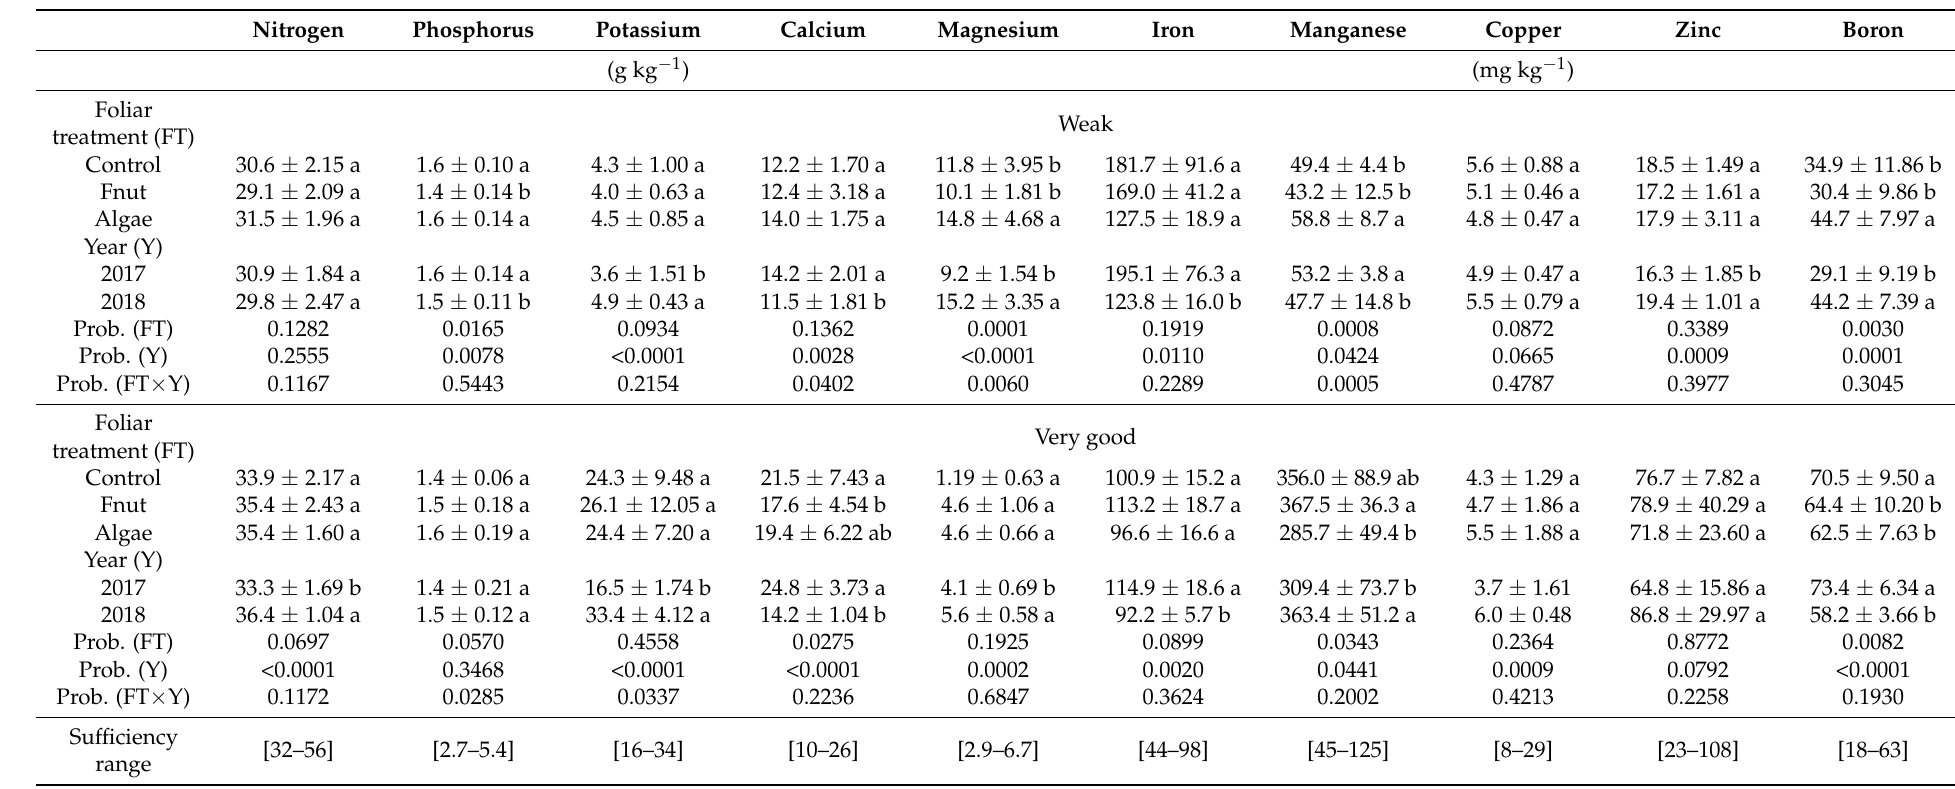
Table 2. Leaf concentrations of macro and micronutrients (average ± standard error) in July from samples taken at 2 m height in the plots of weak and very good vigour plants as function of foliar treatment (Fnut, nutrient-rich foliar spray; Algae, algae-rich foliar spray; and Control), and year. Means followed by the same letter are not statistically different ( α = 0.05) by Tukey HSD (Foliar treatment) or t -Student t (Year)